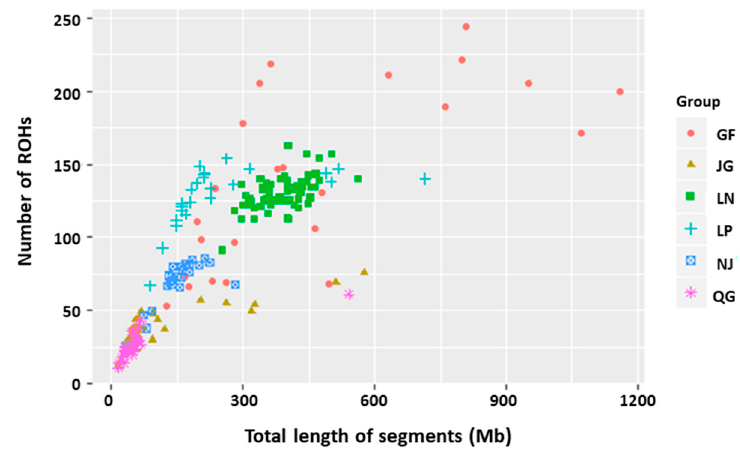
Figure 3. Total genomic length (Megabases) covered by ROH per individual ( x axis) and total number of ROH per individual ( y axis).